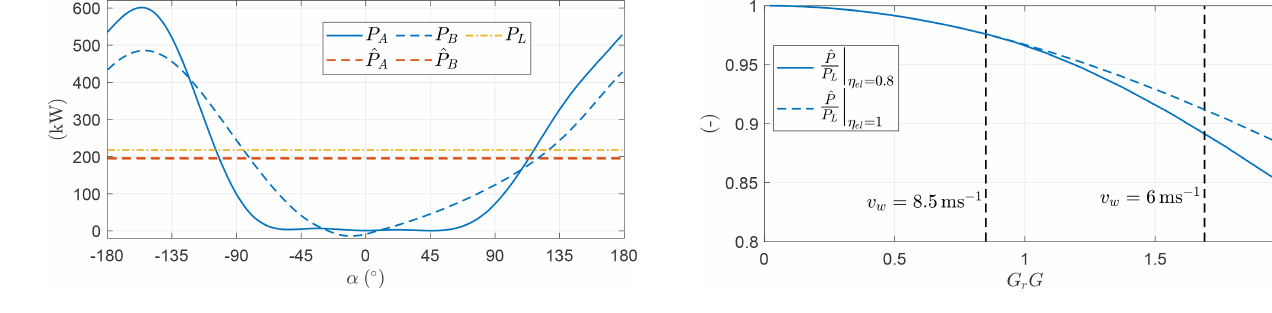
Figure 30. Normalized electrical power for a case with η el = 0 . 8 ( − ) and η el = 1 ( − − ) as a function of G r G .